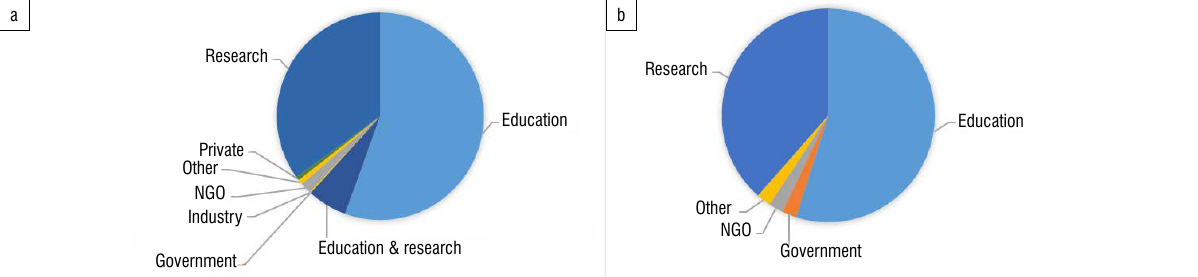
Figure 2: Affiliations represented by (a) African-Arabian and (b) South African submissions. Clean Energy Climate Change Water Digital Revolution